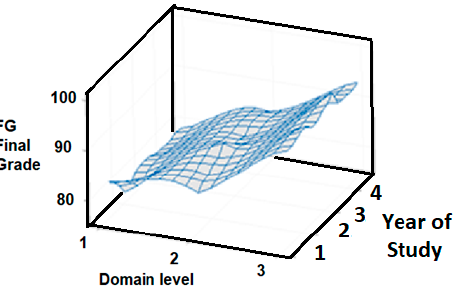
Figure 9. 3D Surface graph of final grade vs. semester (with the domain level as the x axis variable) for the emergency first response competency.